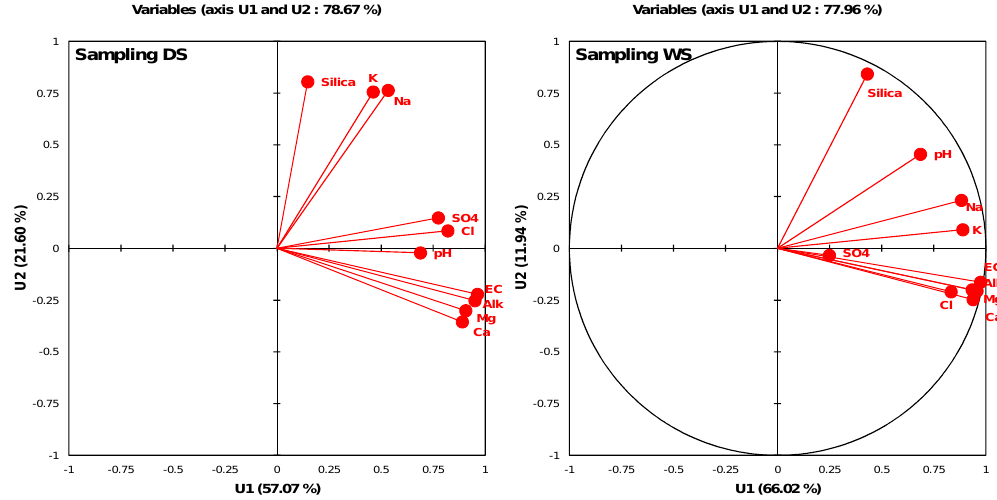
Fig. 6. Variables distribution on the first factorial plan of the PCA 1 carried out on DS and WS samplings.